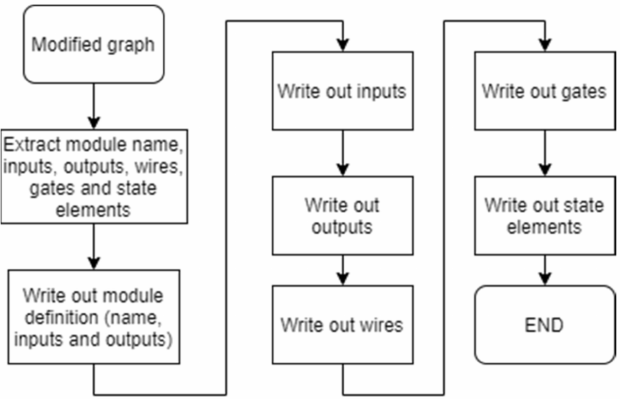
Figure 10. Process of netlist generation from the